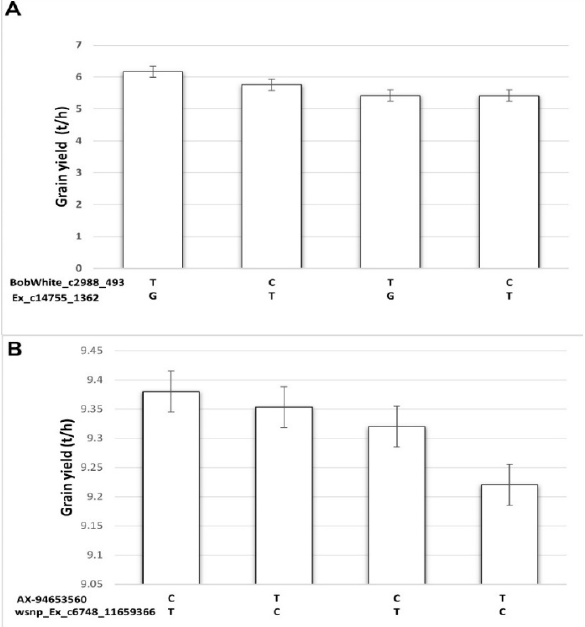
Figure 8. Allele combination of average grain yield from two field experiments performed in ( A ) rainfed conditions and ( B ) irrigated conditions at Sidi Al-Aidi station with 200 bread wheat genotypes having four base–pair combinations of two independent single nucleotide polymorphism markers associated with grain yield: BobWhite_c2988_493 and Ex_c14755_1362 in rainfed ( A ) and AX-94653560 and wsnp_Ex_c6748_11659366 in irrigated ( B ).